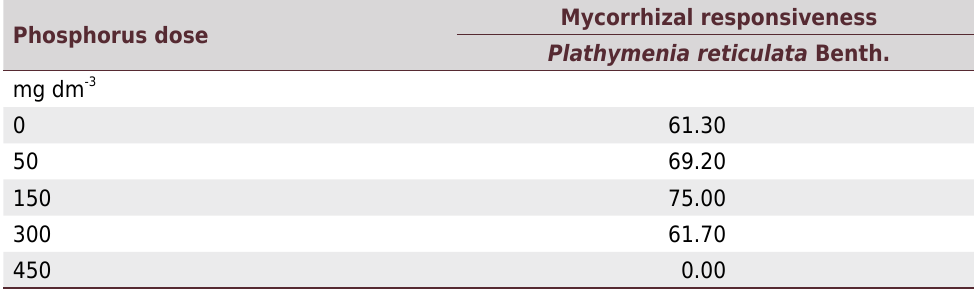
Table 2. Doses of P (mg dm -3 ) for mycorrhizal responsiveness of P. reticulata and M . brauna after 90 days of cultivation in the